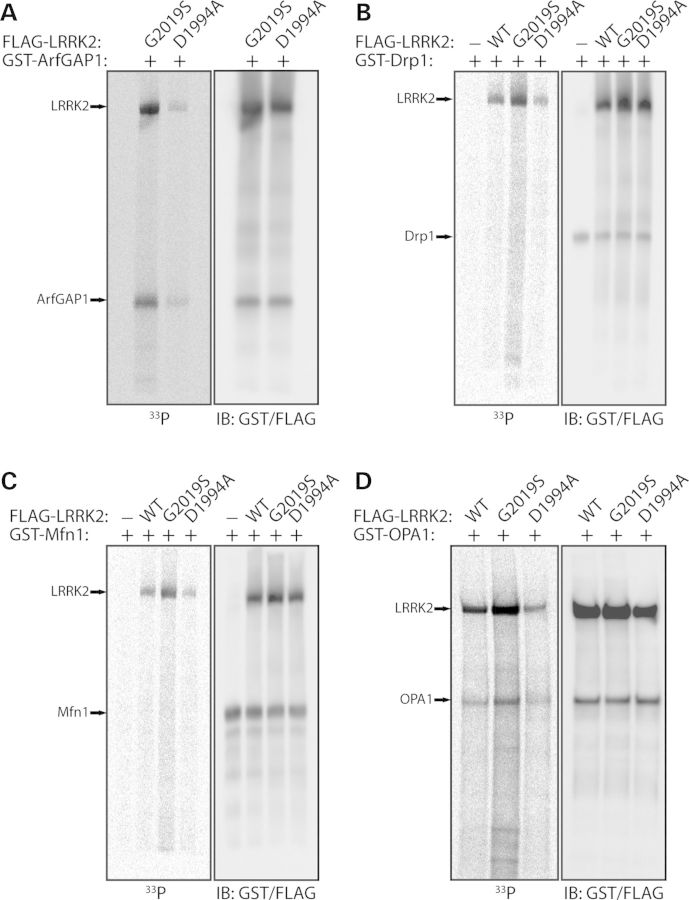
Recombinant OPA1 is phosphorylated by LRRK2 in vitro. In vitro kinase assays with [33P]-γ-ATP, recombinant soluble full-length FLAG-tagged LRRK2 variants (WT, G2019S or D1994A) and recombinant full-length GST-tagged ArfGAP1 (A), Drp1 (B), Mfn1 (C) or OPA1 (D). Western blot analyses with anti-GST and anti-FLAG antibodies indicate equal loading and positions of ArfGAP1, Drp1, Mfn1, OPA1 and LRRK2 proteins in each condition. Autoradiographs (33P) reveal the LRRK2-dependent phosphorylation of ArfGAP1 and OPA1, with enhanced phosphorylation by G2019S LRRK2 compared with WT or D1994A LRRK2. A soluble eluate from FLAG IPs (derived from non-transfected cells) was used as a control in each assay to assess background 33P incorporation for each substrate. LRRK2 autophosphorylation is also detected in these assays. Blots are representative of at least three-independent kinase experiments.